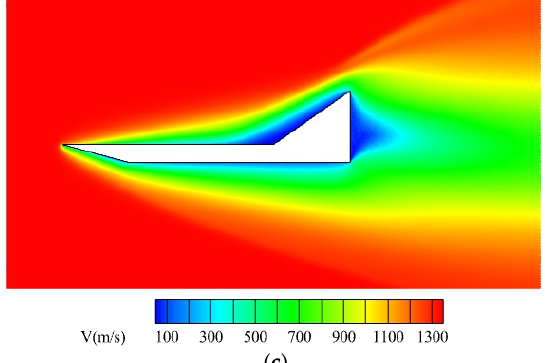
Figure 5. The contour of two-dimensional ramp model ( β = 35°): ( a ) Density; ( b ) Temperature; ( c ) Velocity.